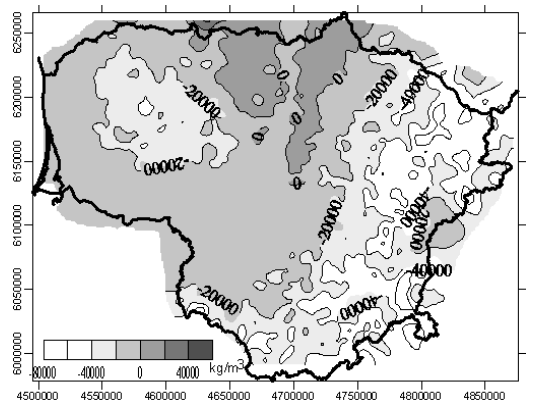
4 pav. Tarpinio sluoksnio tanki ų žem ė lapis Fig 4. Topography densities Uolien ų tanki ų reikšm ė s buvo gautos, panaudojant